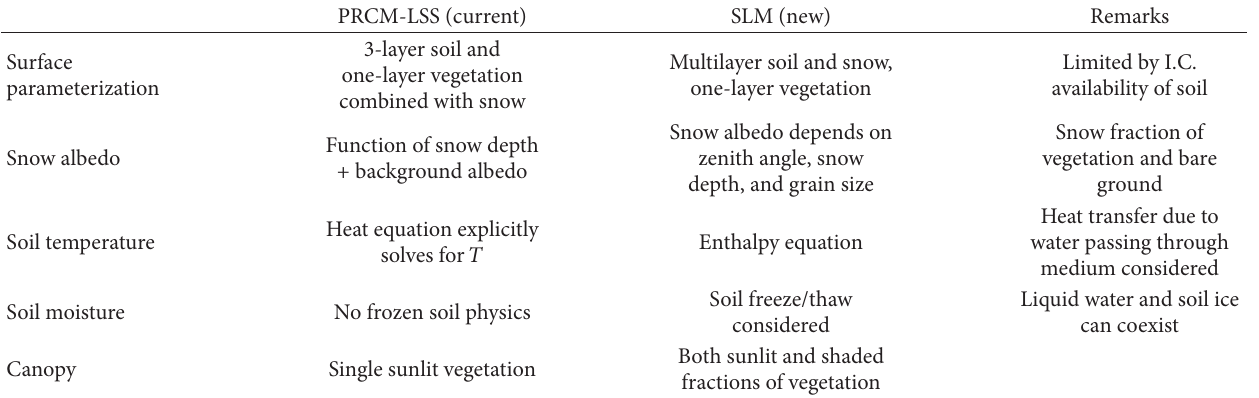
Table 1: Comparison of PRCM land-surface scheme (LSS) with the snow land-surface model